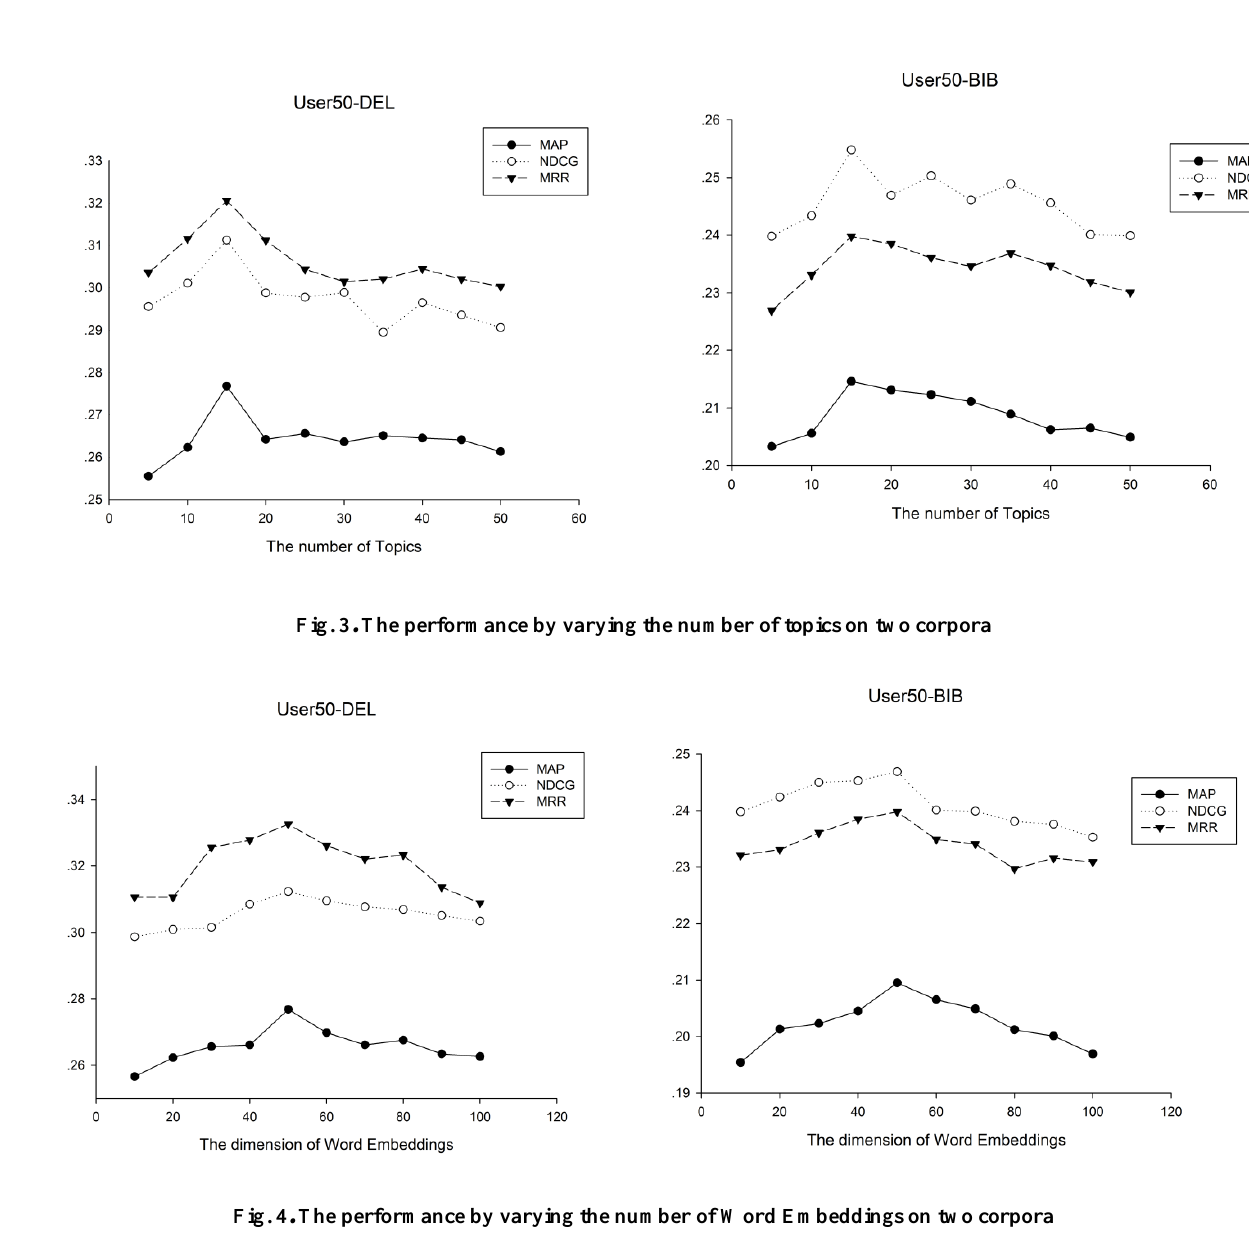
Fig. 4 . The performance by varying the number of Word Embeddings on two